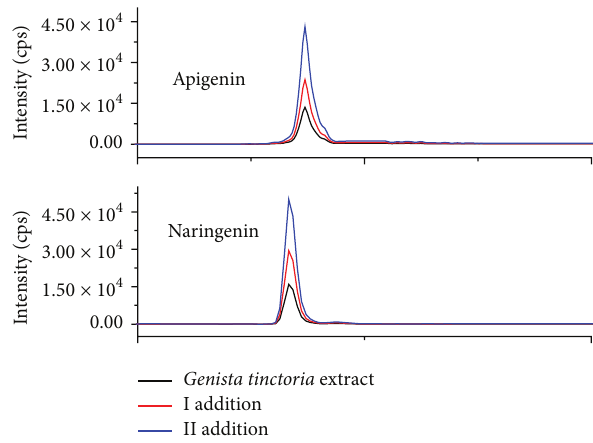
Figure 6: The recovery of apigenin and naringenin in Genista tinctoria extract. I: the addition of 0,5 mg of apigenin or 10 mg of naringenin; II: the addition of 1mg of apigenin or 20 mg of naringenin (mg/g of dried plant in the